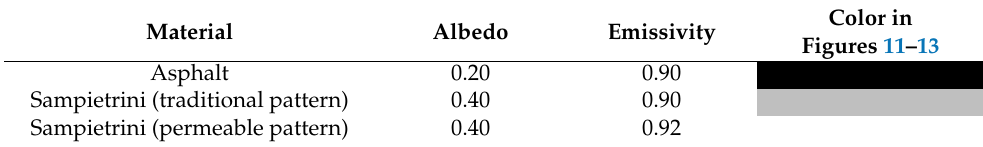
Figure 10. ENVI-Met model of St Peter in Chains’ square with grid and boundaries. Table 2. Physical characteristics of pavement